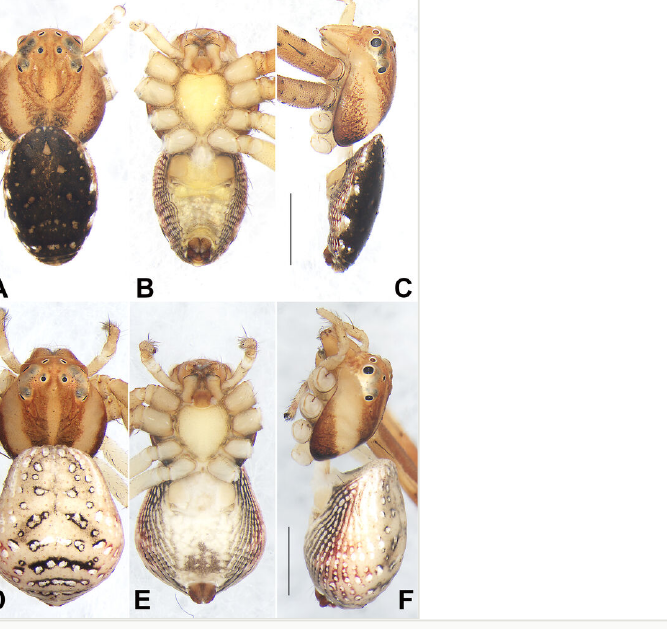
Habitus of Synema guiyang sp. nov., male holotype ( A–C ) and female paratype ( D–F ). A, D Dorsal view; B, E Ventral view; C, F Lateral view. Scale bars: 1 mm (equal for A–C, equal for